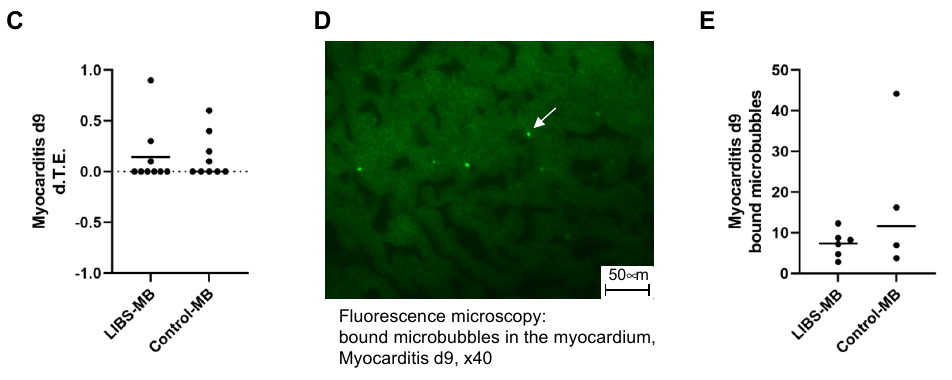
Figure 2. LIBS-MB is not suitable for specific detection of early myocarditis by ultrasound in mice. ( A ) Wash-in of LIBS-MB directly after bolus injection depicted via B-mode on the left and non-linear contrast mode on the right in the parasternal short axis. ( B ) Residual signal of LIBS-MB after 8 min, when imaging was resumed right before bursting depicted via B-mode on the left and non-linear contrast mode on the right in the parasternal short axis. The left ventricular myocardium is shown as ROI within the green frame and shows no macroscopically visible residual signal. ( C ) The differential Targeted Enhancement of both LIBS-MB ( n = 9) and control-MB ( n = 9) in the myocardium of myocarditis mice on day 9 obtained by contrast echocardiography shows no selective binding of either contrast agent (Wilcoxon test, two-tailed, paired). ( D ) Fluorescence microscopy in 40× magnification, showing bound microbubbles in the myocardium of myocarditis mice on day 9, as exemplarily shown by the white arrow. ( E ) Counting of bound microbubbles in the myocardium of myocarditis mice on day 9 supports the ultrasound findings: No significant difference between binding of LIBS-MB ( n = 6) and control-MB ( n = 4) could be observed (Mann–Whitney test, two-tailed).